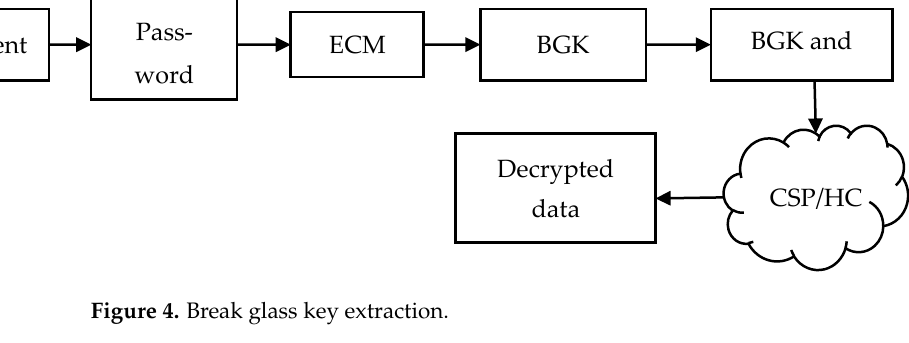
Figure 4. Break glass key extraction.